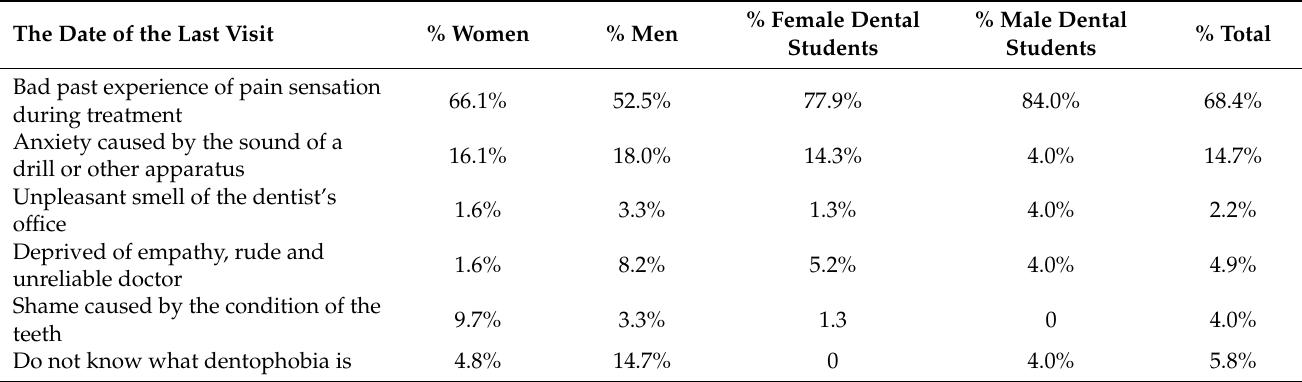
Table 4. The most common cause of dentophobia.